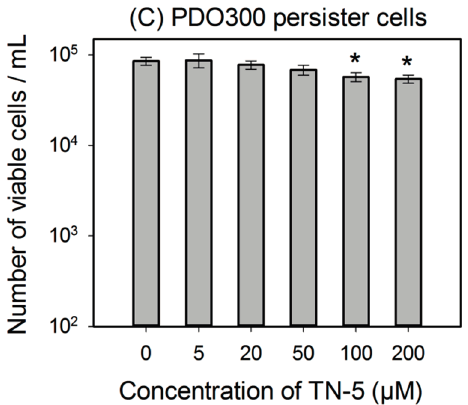
Figure 3. Effects of TN-5 on persister cells of E. coli RP437 ( A ), P. aeruginosa PAO1 ( B ), and PDO300 ( C ). The persister cells were isolated by treating exponential cultures of E. coli RP437 with 100 µg/mL ampicillin and overnight P. aeruginosa cultures with 200 µg/mL ciprofloxacin (both for 3 h). All significant differences (compared to the TN-5 free control) with p < 0.01 are marked with an asterisk.